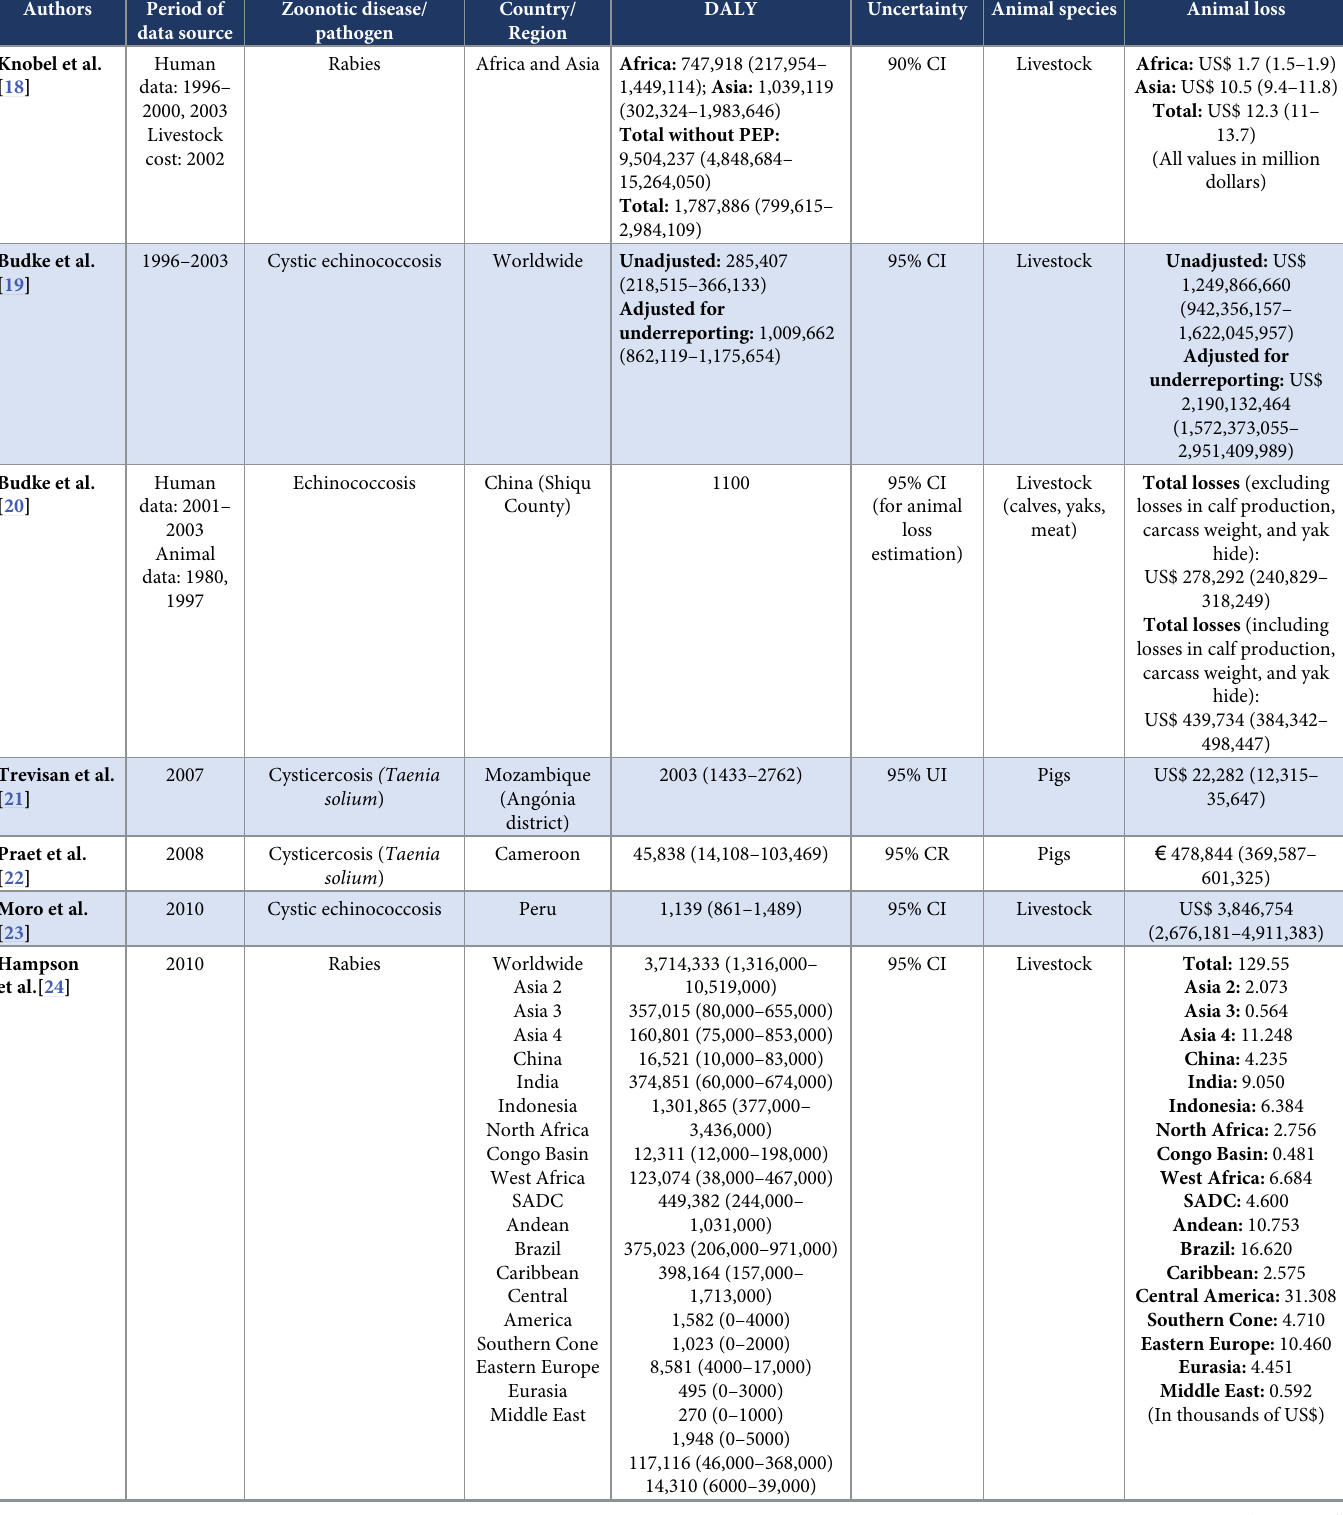
Table 1. Findings in the dual burden of zoonoses (ordered by ascending year of the data